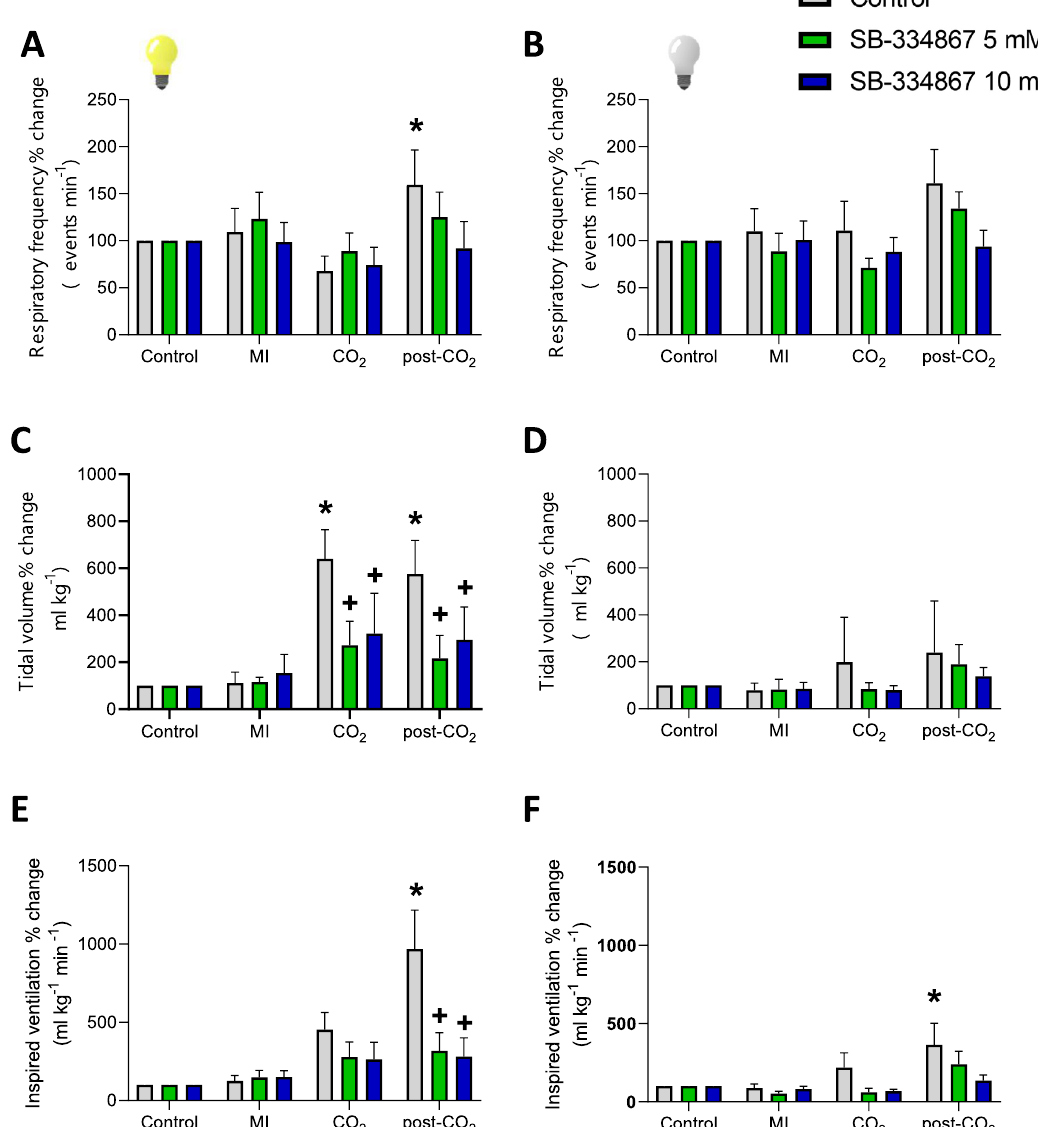
Figure 6. Effect of SB-334867 on CO 2 -chemoreflex. Effect of the i.c.v. microinjection (MI) of SB-334867 and ˙ V its vehicle on f R , V T and I in green iguanas exposed to acute hypercarbia (5% CO 2 ) during light or dark phases. Data reported as means ± s.e.m. * means different from vehicle. The effect of hypercarbia (vehicle group, no drug) is indicated by * compared to control, while + represent the statistical differences caused by the effect of the